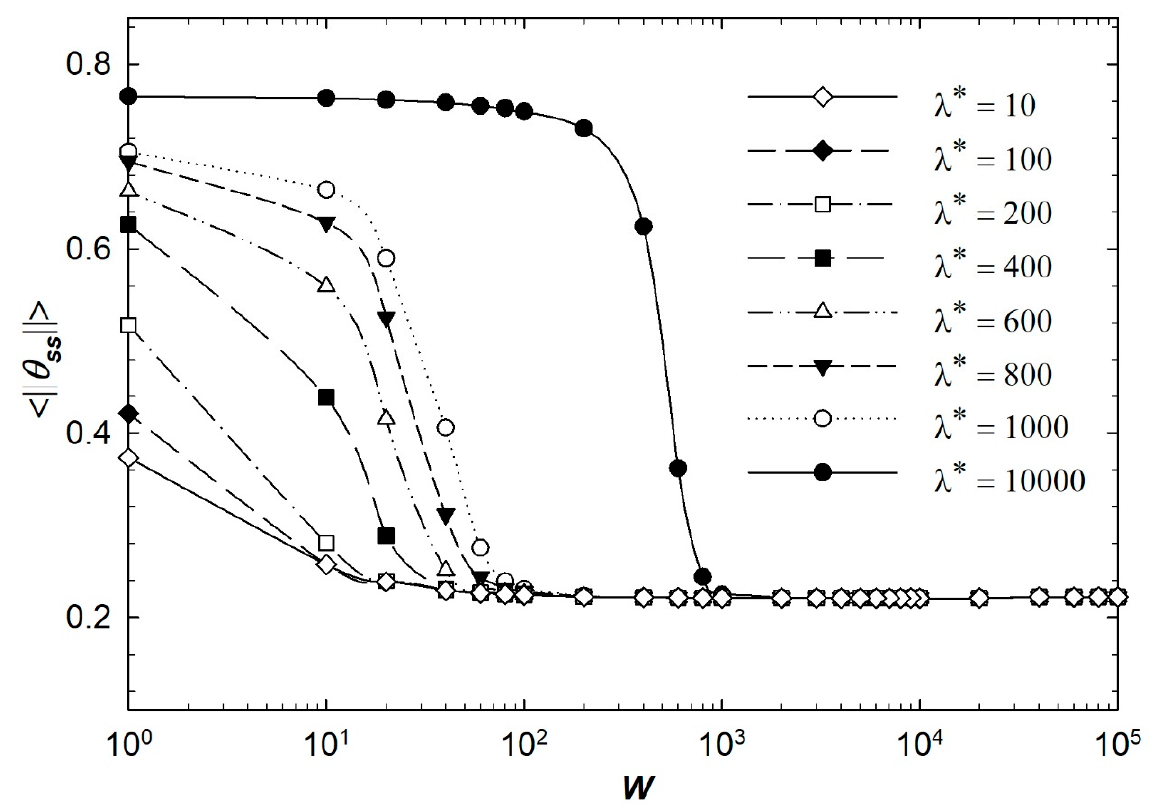
Figure 7. Mean magnitude of the polar angle <|| θ ss ||> at steady state versus dimensionless anchoring energy for different ranges of dimensionless surface viscosity parameter.